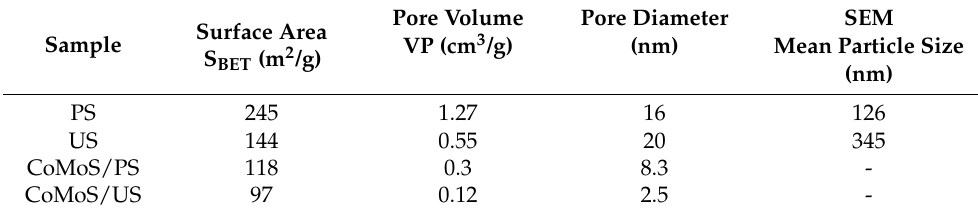
Figure 2. N 2 adsorption–desorption isotherm: ( a ) US and PS and ( b ) CoMoS/PS and CoMoS/US. The inserts in ( a , b ) show the pore size distributions. Table 1. Summary of textural properties and particle size of supports and CoMoS catalysts.